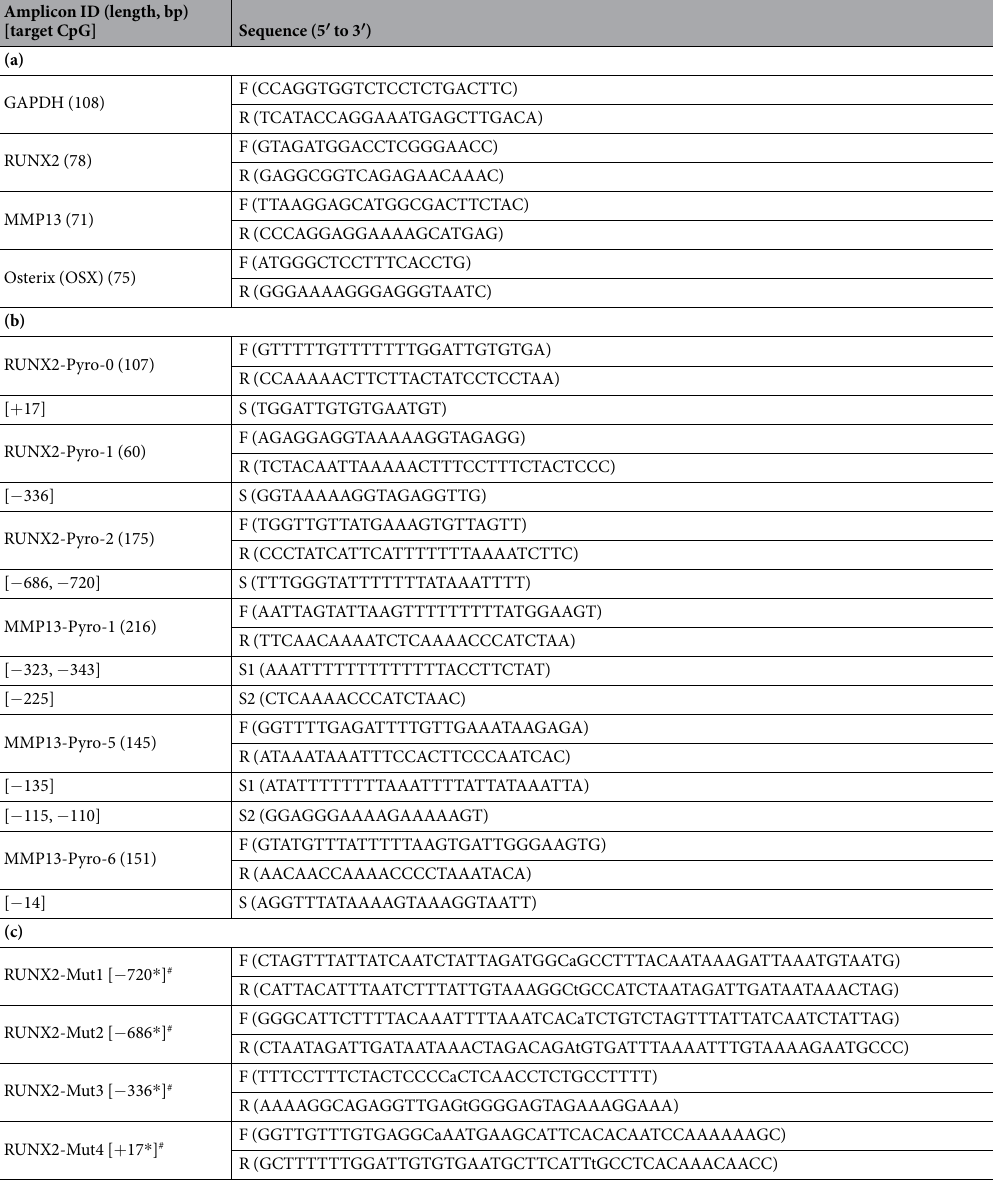
Table 1. (a) Primer sequences for qRT-PCR, (b) Primer sequences for pyrosequencing, and (c) site directed mutagenesis. * Location of mutated CpG, # Lowercase letters indicate a mutated base, F: forward; R: reverse; S: